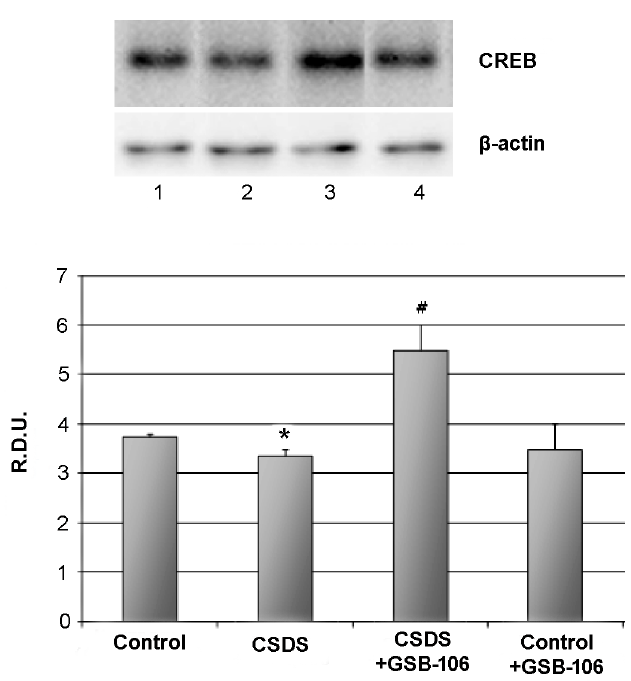
Figure 3. Dipeptide GSB-106 completely restores decreased CREB level in hippocampus of CSDS mice.Western blot analysis data. R.D.U—relative densitometric units. Lanes: 1—Control, 2—CSDS, 3—CSDS + GSB-106, 4—Control + GSB-106. Data are presented as means and standard errors of the mean. *— p < 0.05 as compared to the “Control “ group, #— p < 0.05 as compared to the “CSDS” group (Mann–Whitney U test). There was no statistically significant difference between the β -actin